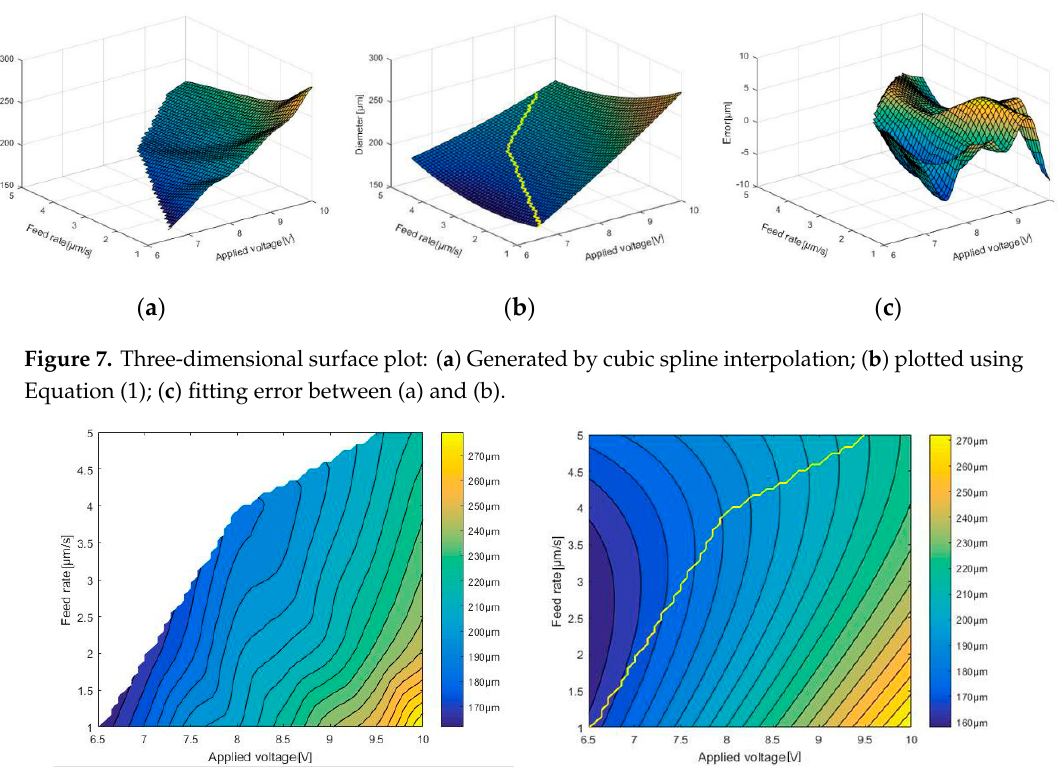
Figure 8. Contour plot: ( a ) Generated by cubic spline interpolation; ( b ) plotted using Equation (1).